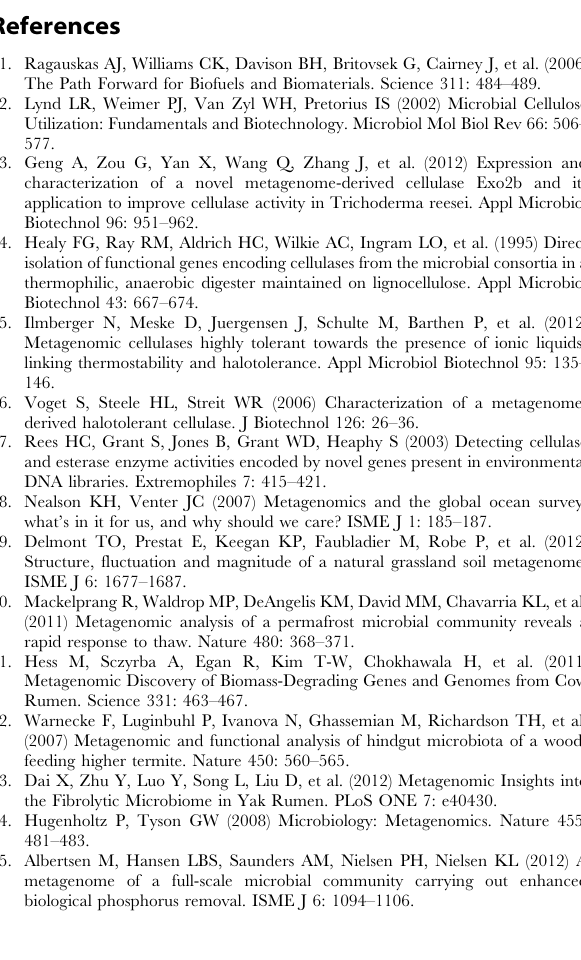
Table S3 Glycoside hydrolases from the enriched thermophilic cellulolytic culture. Table S4 Carbohydrate binding modules from enriched thermophilic cellulolytic culture. Table S5 Comparison between metagenomic study of cow rumen microbes (10) and this